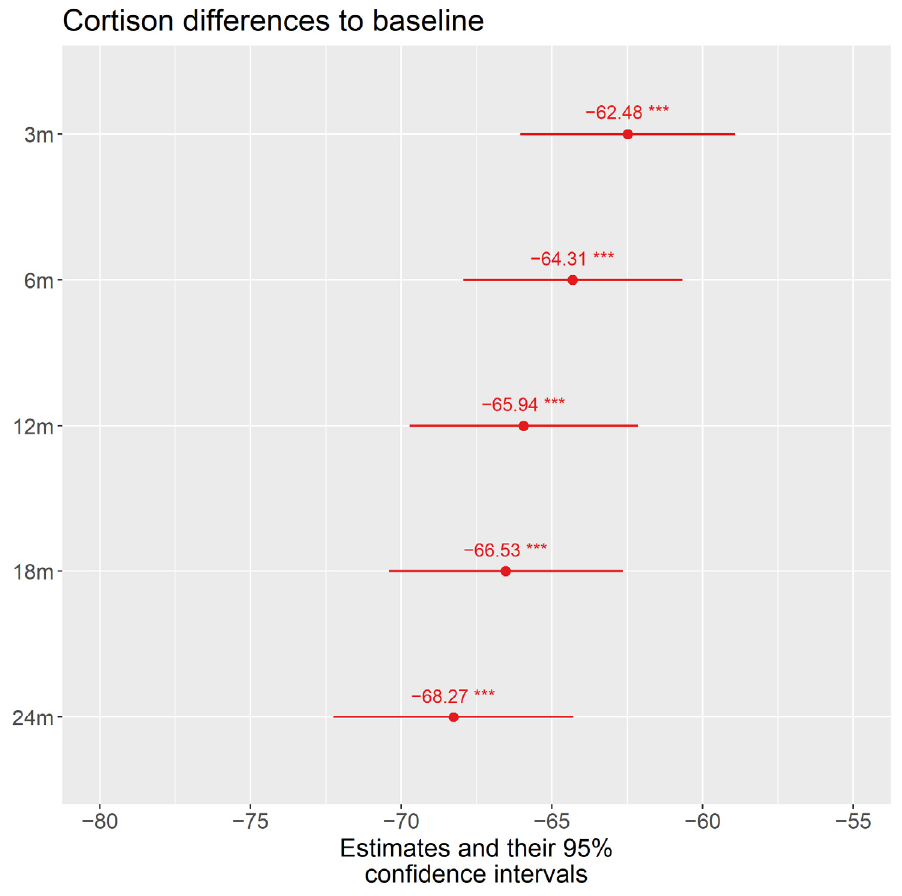
Figure 3. Shows the patients’ daily demand of systemic corticosteroids (mean dosage in mg/day and their 95% confidence intervals) in contrast with the initial visit FUO (71.03 mg/d) and the mean decrease at FU1 (month 3 visit: − 62.48 mg/d), FU2 (month 6 visit: − 64.31 mg/d), FU3 (month 12 visit: − 65.94 mg/d), FU4 month 18 visit: − 66.53 mg/d), and FU5 (month 24 visit: − 68.27 mg/d); m = months. p value *** 0.001.